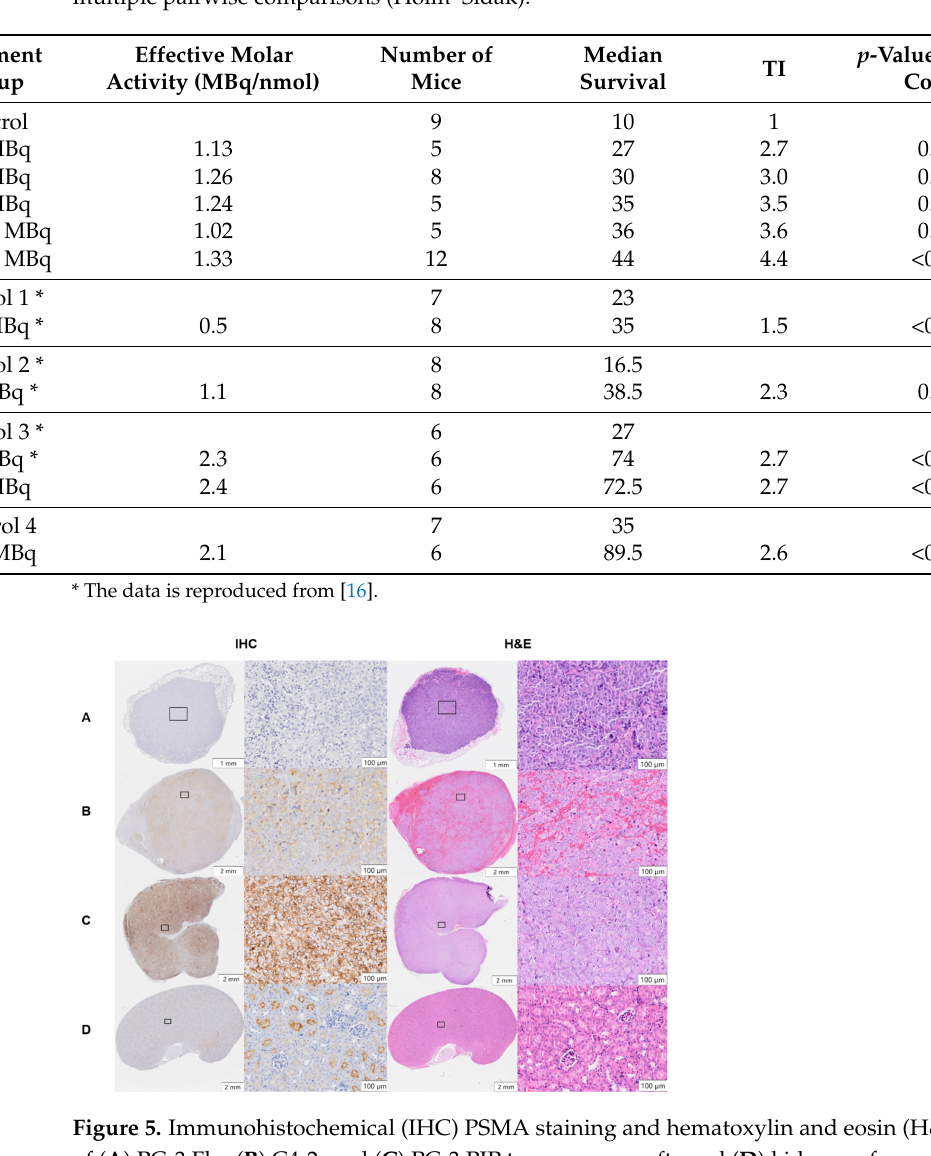
Table 1. Median survival and therapeutic index (TI) of 212 Pb-NG001 in athymic nude mice with PC-3 PIP xenografts. The TI was calculated from the median survival of the treated group divided by the median survival of the control group. Statistical significance was estimated by a log-rank test with multiple pairwise comparisons (Holm–Sidak).